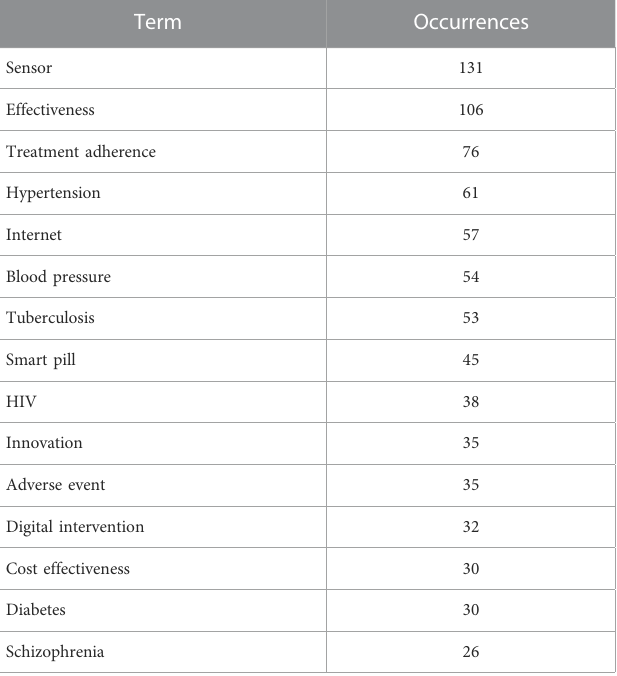
TABLE 5 The top keywords in publishing and scienti fi c activity in the fi eld of digital pills for the period January 2012 to July 2022.